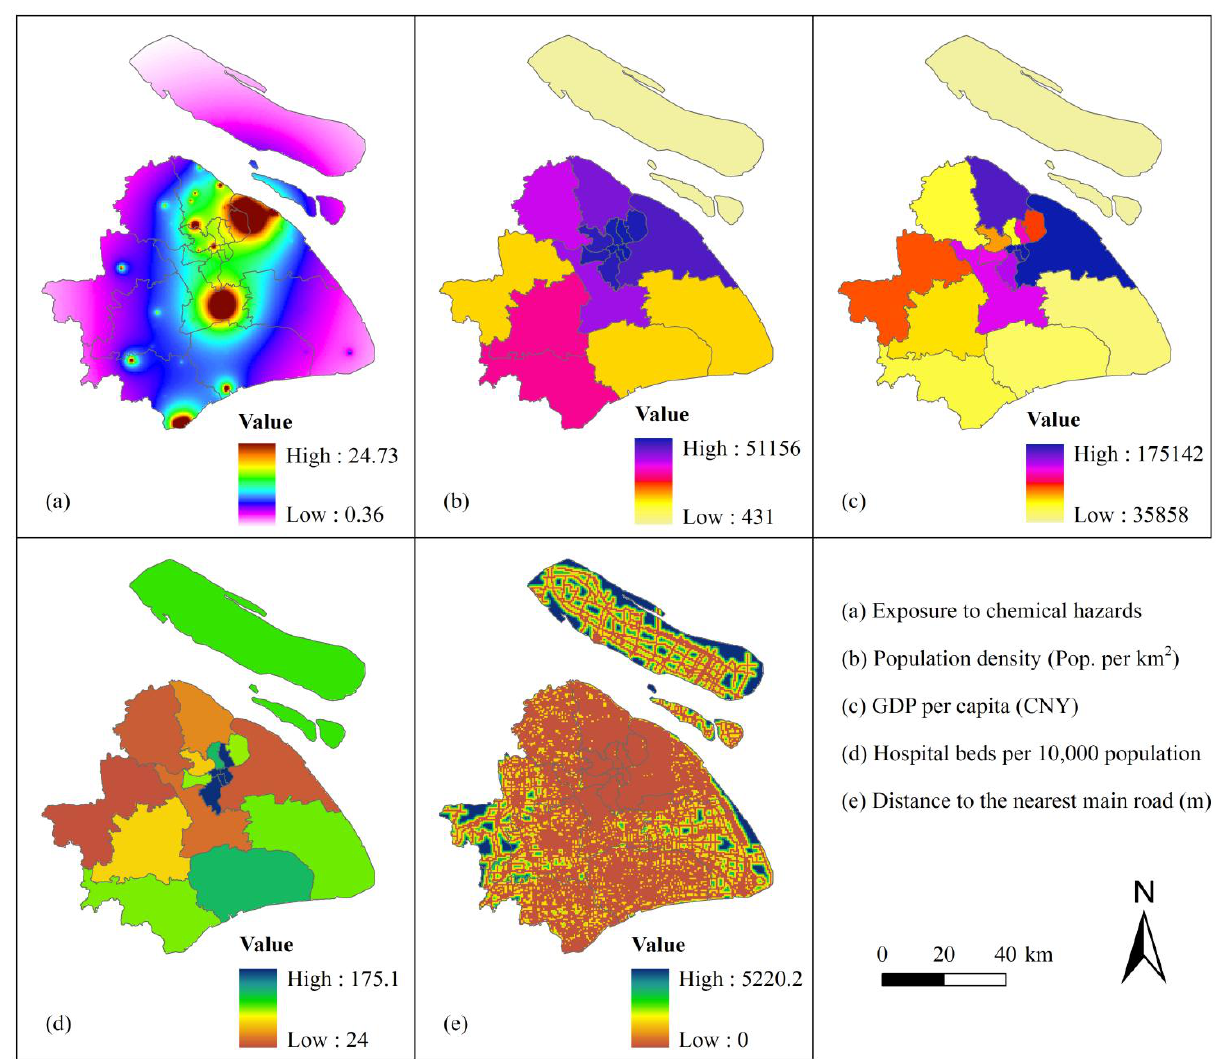
Figure 3. Spatial distribution of indicators of human vulnerability to chemical hazards in Shanghai (CNY: Chinese yuan, the currency of